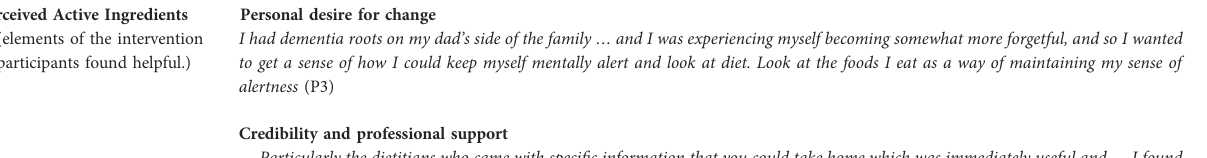
Perceived Active Ingredients (elements of the intervention participants found